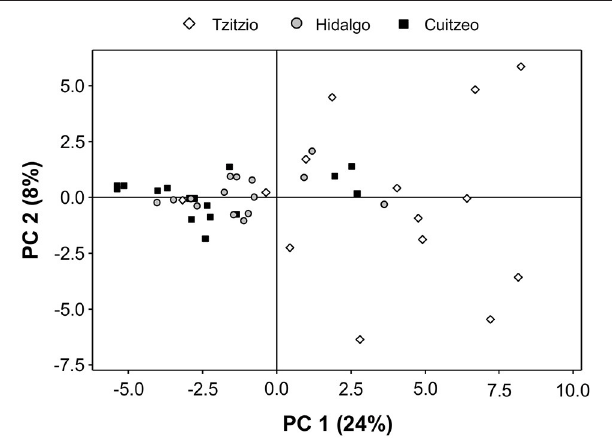
FIGURE 4 | Principal component analysis (PCA) of herbivore-induced plant volatile emissions. Plants from three different teosinte populations were compared: Tzitzio ( Zea mays ssp. parviglumis ), Hidalgo ( Z. mays ssp. mexicana ), and Cuitzeo ( Z. mays ssp. mexicana ). Volatiles were collected from plants that were infested with Spodoptera frugiperda larvae in the absence of parasitoid wasps (treatment SF). The PCA shows the first and second principal components (PC) with the explained variance in brackets.